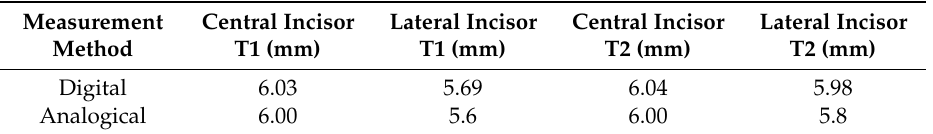
Table 3. Mean distances between the cusp of the canines and the apical point of the gingival margins of the central and lateral incisors at T1 (2 months) and T2 (4 months) calculated with digital and analogical methods.